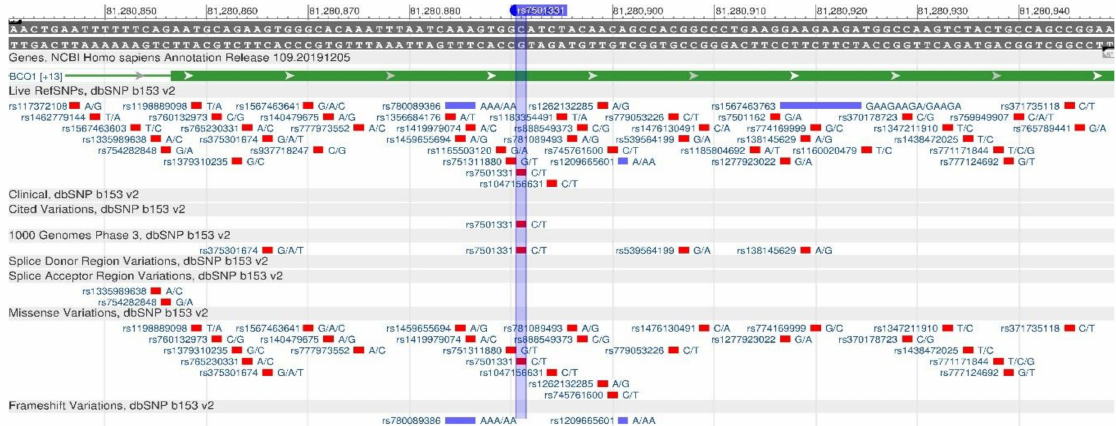
Figure 15. The BCMO1 gene region (located on the long (q) arm of chromosome 16) containing the oligonucleotide polymorphism